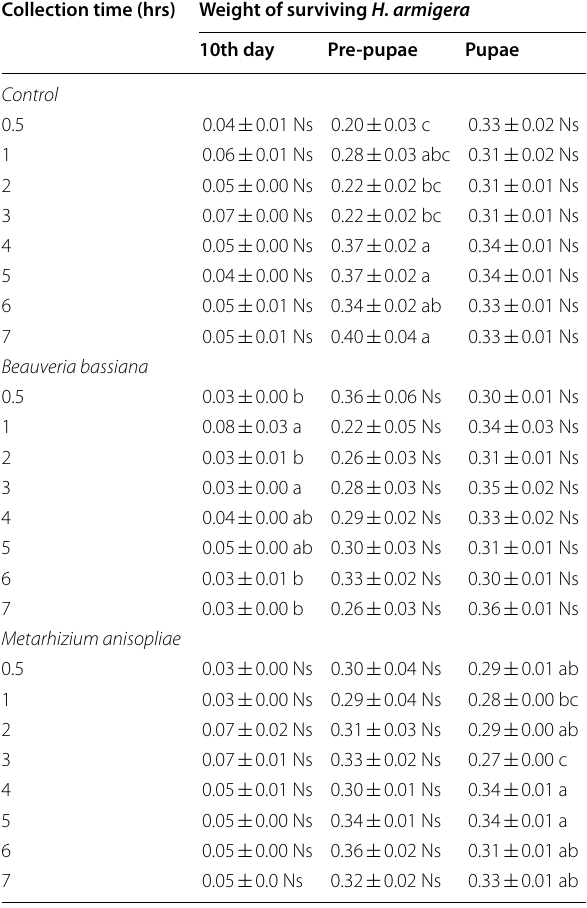
Means followed by the same lowercase letters in rows did not differ significantly by Tukey’s test at 5% probability Ns Not significant